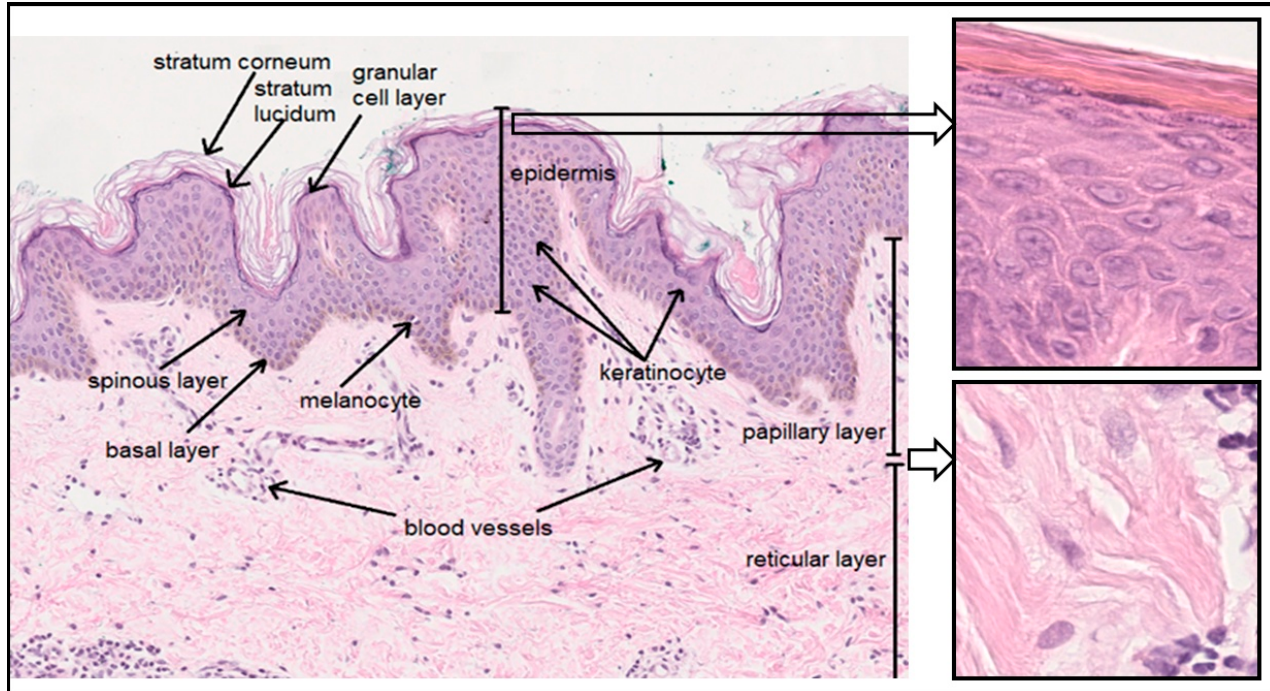
Figure 1. Skin structure (own work, photo: Department of Clinical and Experimental Pathology, Medical College, Jan Kochanowski University).